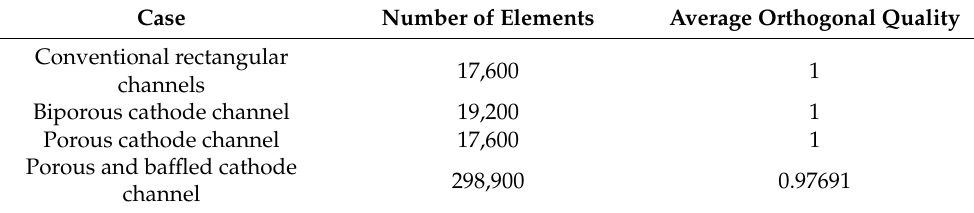
Table 1. Grid independent meshes number of elements and orthogonal quality for each